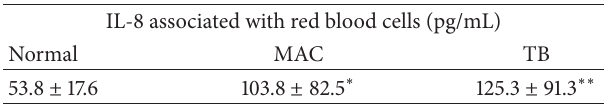
Table 1: Concentration of IL-8 (pg/mL) associated with red blood cells in human blood from: normal subjects (7 subjects), patients infected with MAC (13 patients), and patients infected with TB (14 patients).